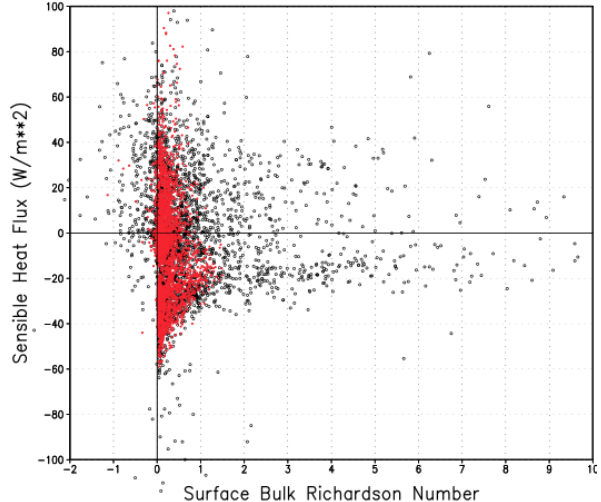
Figure 5. Surface bulk Richardson number as a function of sensible heat flux in Wm − 2 in a single July from experiment 3 (red) and experiment 2